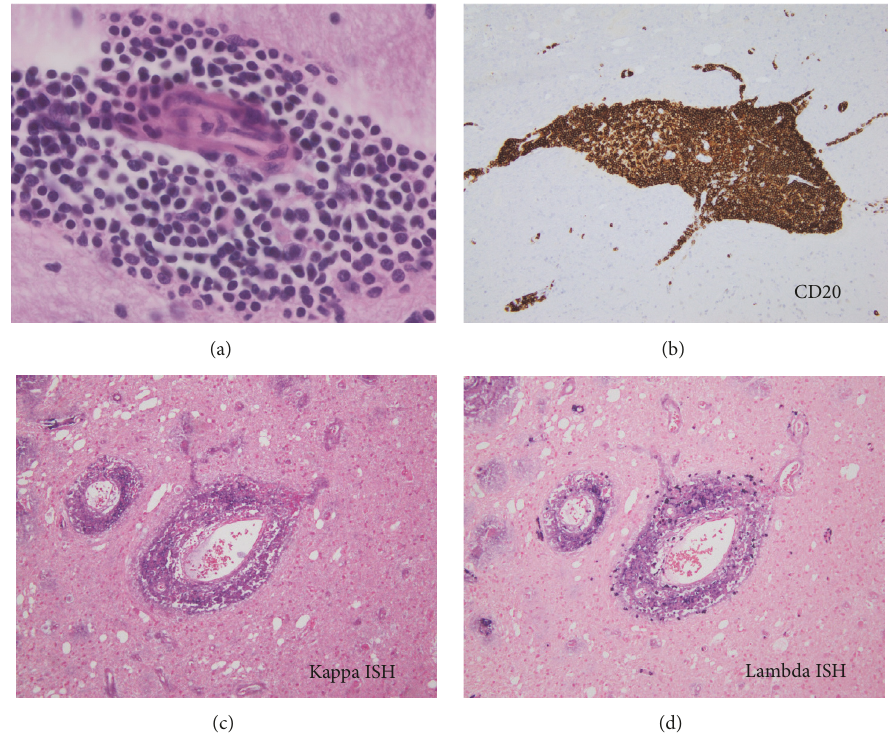
Figure 3: (a) Perivascular infiltrate highlighting the lymphoplasmacytic appearance of the cells, hematoxylin and eosin stain, original magnification 600x. (b) Immunohistochemical stain for CD20 highlights a perivascular infiltrate of B-cells, original magnification 200x. (c) and (d) Positive staining of the tumor cells for lambda light chains but not for kappa light chains signifies lambda light chain restriction, in situ hybridization, original magnification